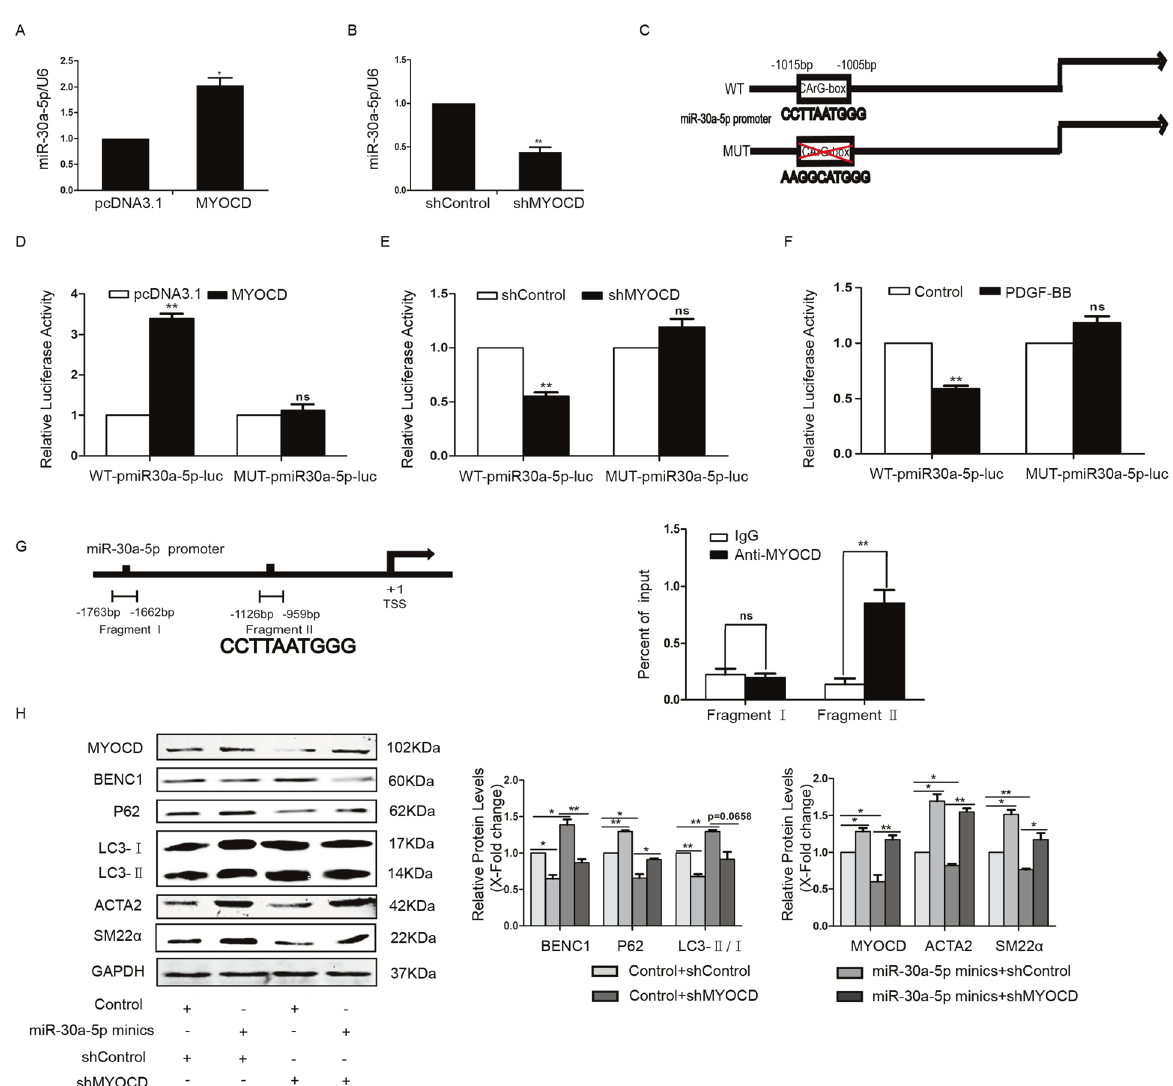
Fig. 3 MYOCD activated the transcription of miR-30a by binding to the CArG box. The level of miR-30a-5p was examined in MYOCD overexpression ( A ) or knockdown ( B ) cells by RT-PCR (* P < 0.05, ** P < 0.01, n = 3). C A schematic diagram of the miR-30a-5p promoter region represents wild-type and mutant CArG boxes. D Luciferase reporter plasmids together with pcDNA3.1-MYOCD plasmids or vectors were cotransfected into HA-VSMCs, and 24 h after transfection, luciferase activity was assayed (** P < 0.01, n = 3). E HA-VSMCs were transfected with luciferase reporter plasmids together with shControl or shMYOCD plasmids for 24 h, and then luciferase activity was assayed (** P < 0.01, n = 3). F HA-VSMCs were transfected with luciferase reporter plasmids in the presence or absence of PDGF-BB for 24 h, and then luciferase activity was assayed (** P < 0.01, n = 3). G 48 h after transfection of pcDNA3.1-MYOCD-myc vector expression plasmids or vector plasmids, ChIP assays were performed using antibodies against myc (** P < 0.01, n = 3). H MiR-30a-5p mimics were transfected into MYOCD knockdown cells, and then western blotting was performed (* P < 0.05, ** P < 0.01, n =